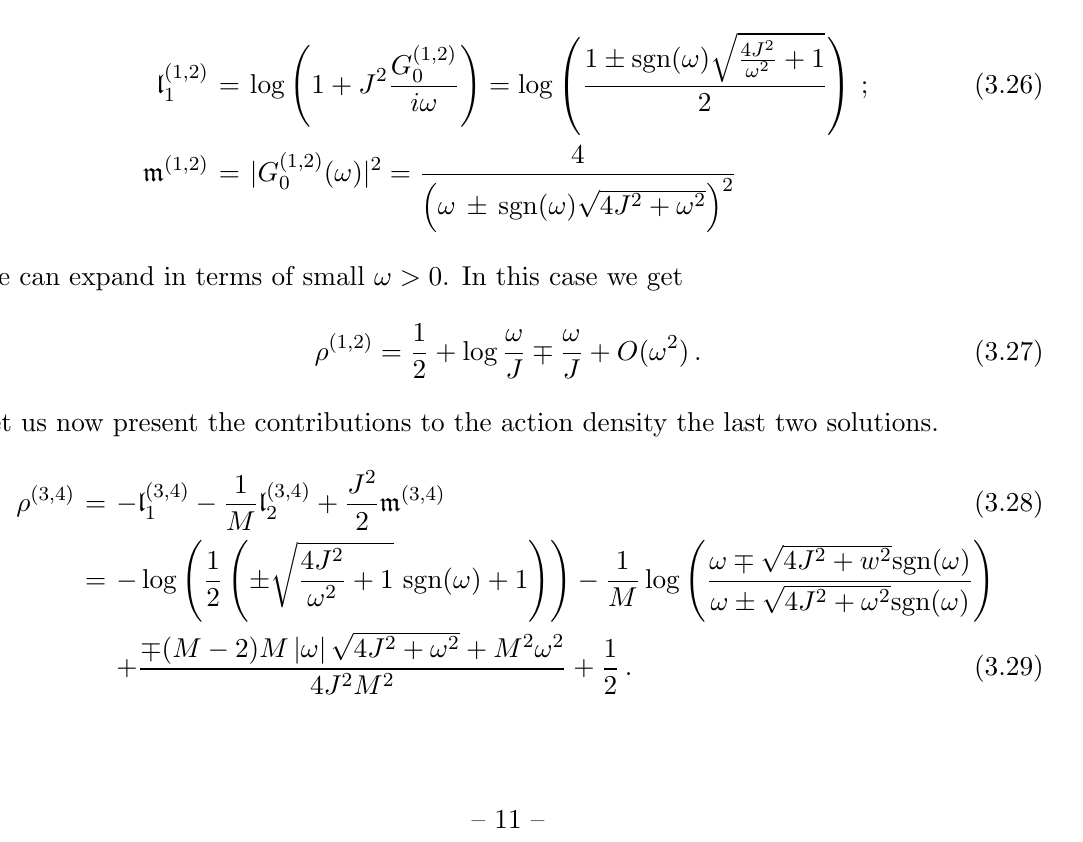
Figure 2 . First line: the difference ρ (non-diag) dominance of the diagonal solution are shown by gray color. Second line: the difference ρ (3) as a function of ω and M